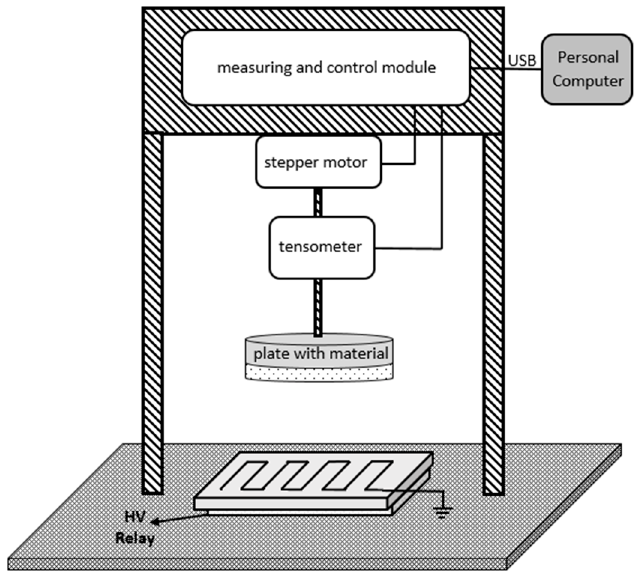
Figure 2. Diagram of the measuring setup.